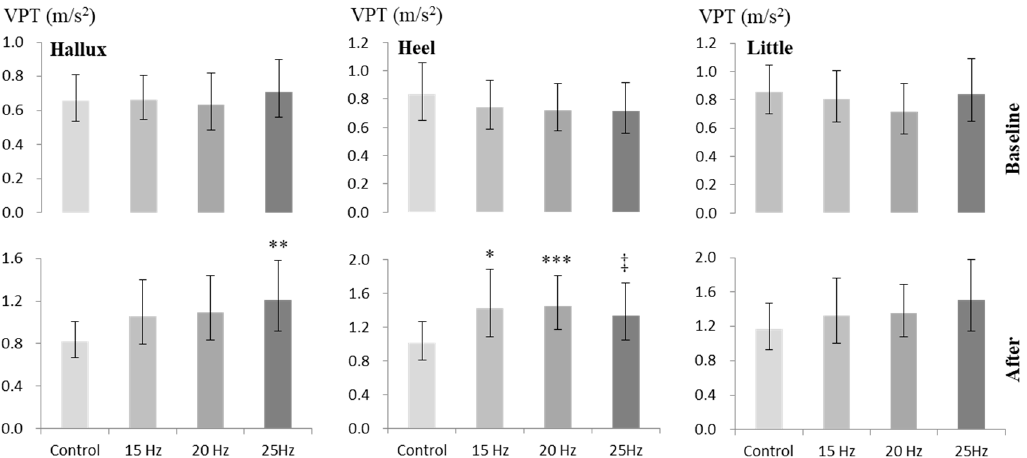
Figure 3. VPT (dB) at the hallux (left panel), heel (middle panel) and little (right panel) finger at baseline (upper panel) and after intervention (lower panel) under 4 different exposure conditions (n = 29). Values are presented as geometric mean and 95% CI (shown as error bars). Levels of differences from the corresponding control values by repeated measures ANOVA with adjustments for multiple comparisons by Bonferroni corrections: *** p < 0.005, ** p < 0.01, * p < 0.05; ‡ p = 0.06. After intervention, compared to the control value at the hallux, VPT increased significantly under 25 Hz vibration exposure condition only ( p < 0.01). Compared to the control value at the heel, the increase in VPT was significant under 15 Hz ( p < 0.05) and 20 Hz ( p < 0.005) exposure conditions, significance; p = 0.063). At the little finger, the after-intervention values of VPT under vibration conditions did not differ significantly from the control value. When multiple comparisons were made between the after-intervention values of VPT obtained under 15, 20 and 25 Hz vibration exposure conditions, no significant differences could be revealed between those values. Table 1 represents the effects of the intervention under 4 exposure conditions on the balance and mobility tests that were assessed by OLS test (eyes open and closed), PW test, TUG test, and CS-30 test. As the results show, the before-exposure values for any of the tests did not differ significantly between the four exposure conditions. Also, after intervention, no statistically significant WBV- induced improvements in those tests could be revealed from comparison of the values of different tests with the corresponding control values. Table 1. The results of balance and mobility tests obtained before and after intervention under different exposure conditions. Values are shown as geometric mean (95% CI) (n = 30). Test